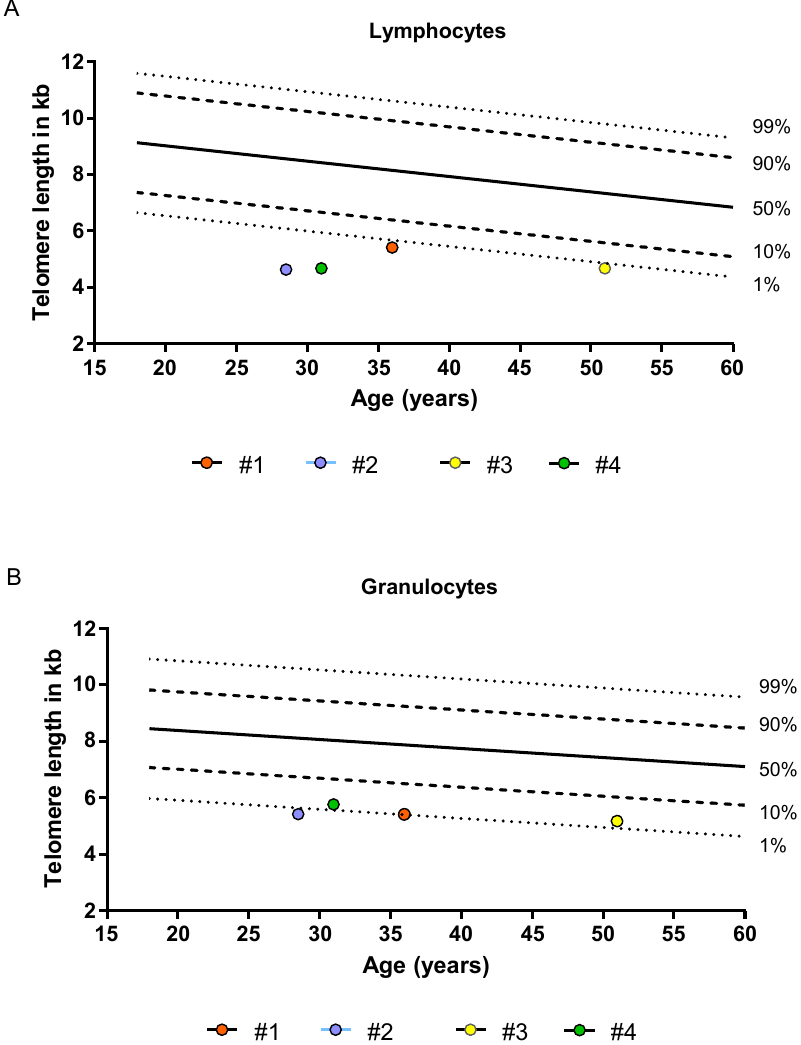
Figure 1. Telomere length of four patients analyzed in comparison to telomere length distributions derived from healthy individuals. Telomere length was assessed with flow-FISH as previously described [24–26]. ( A ) Lymphocyte telomere length ( B ) Granulocyte telomere length. The dashed and dotted lines represent the respective percentiles (1%, 10%, 50%, 90% and 99%) of healthy individuals.